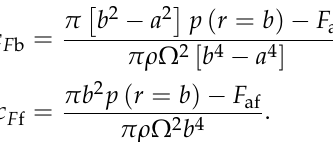
Figure 1. A schematic of the large rotor–stator cavity test rig. The dashed lines indicate the pressure measurements; measured torque coefficients c M correspond to the torque acting on the surface indicated by the red line.